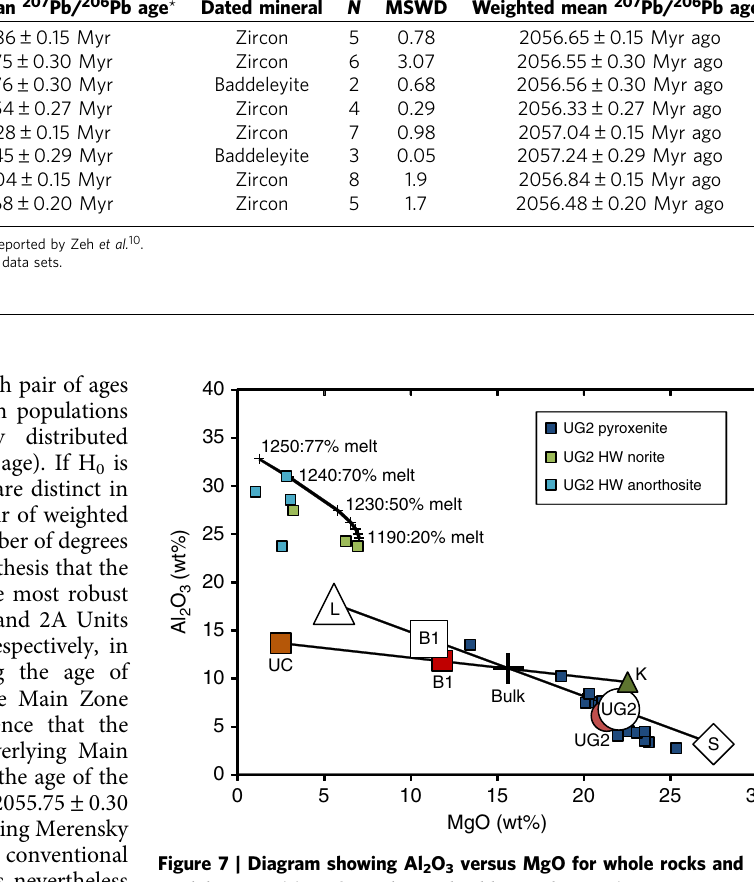
Table 1 | Summary of U–Pb ages for rocks from the Critical and Main zones. Sample no. Rock Unit